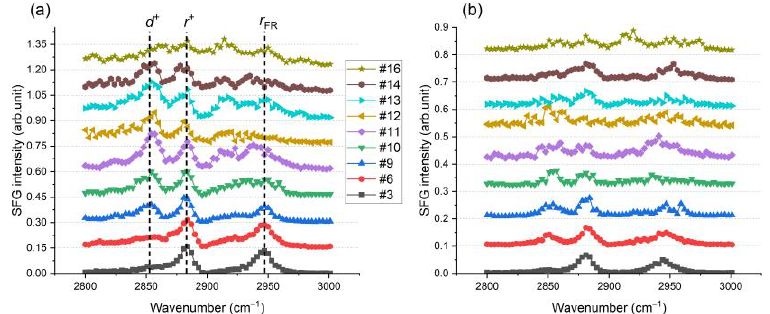
Figure 3. SFG spectra of the hybrid films under ( a ) dry and ( b ) wet conditions (SSP). The intensities of the whole SFG spectra are normalized by the intensities of the peak at 2882 cm − 1 of the symmetric stretching of the methyl group ( r + ) and are offset upward for clarity.